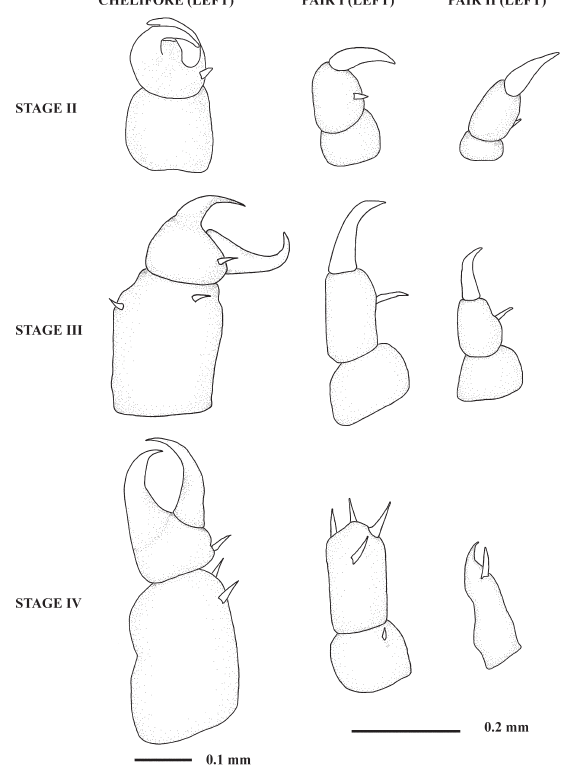
Fig . 2. – larvae of Ammothea glacialis (Hodgson, 1907). Chelifores and larval II-III appendages of the three instar larvae.